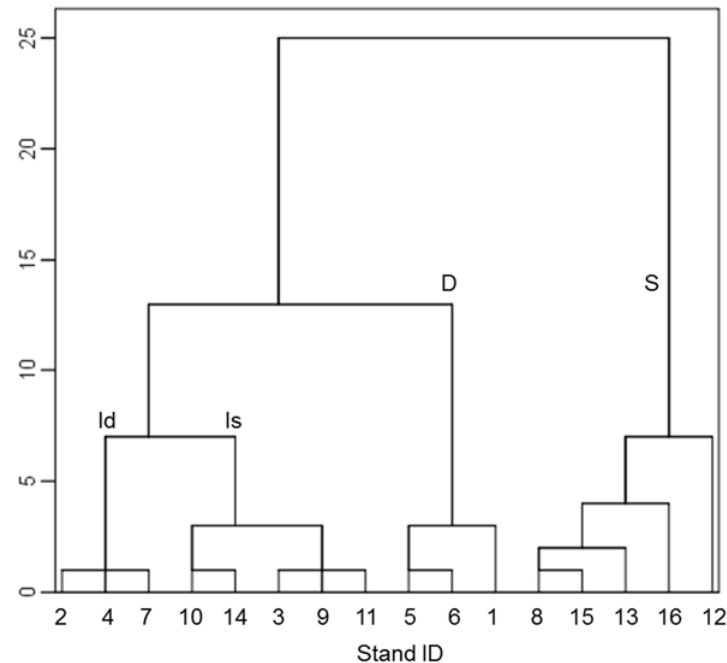
Figure 2. Hierarchical cluster analysis of 16 old-growth stands using Ward linkage, square Euclidean distance and Amalgamation steps as similarity measurements. Variables are shown in Table 2. Group S: shade-tolerant species dominant stands, Group D: Douglas-fir dominant stands, Group Id and Is: Intermediate